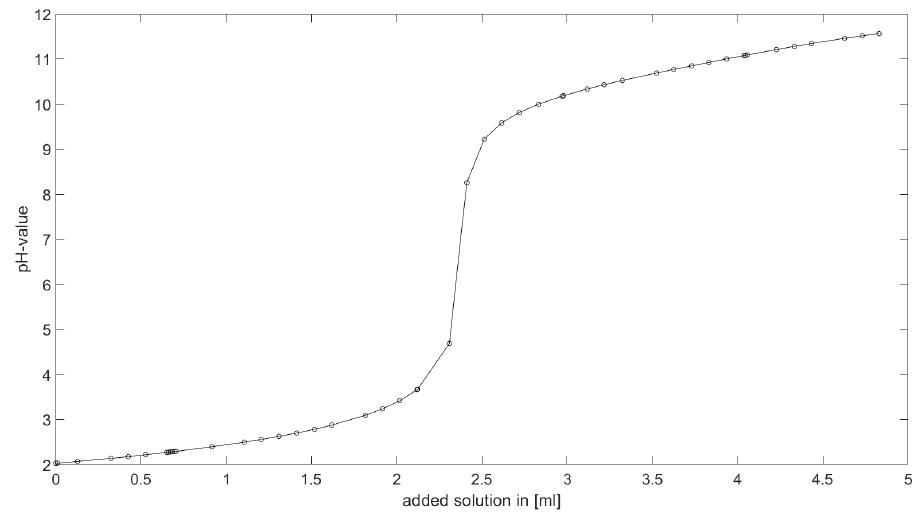
Figure 3. Calculated titration curve with the model associated with the complexes and stability constants as described in Table 1.